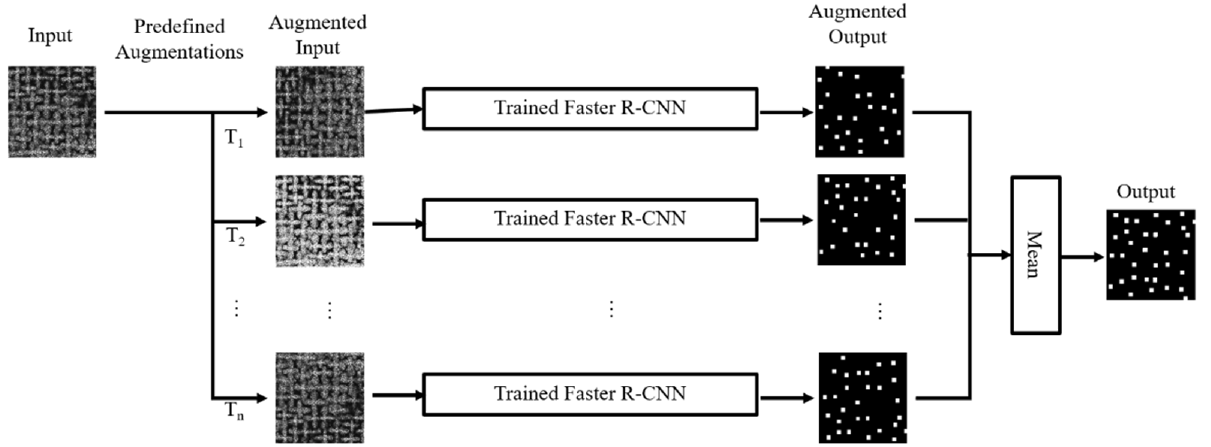
Crystals 2021 , 11 , x FOR PEER REVIEW Figure 4. The process of TTA Faster R-CNN to extract dendrite cores. T1, T2…Tn means augmenta- Figure 4. The process of TTA Faster R-CNN to extract dendrite cores. T1, T2 . . . Tn means augmentation algorithm. tion algorithm.